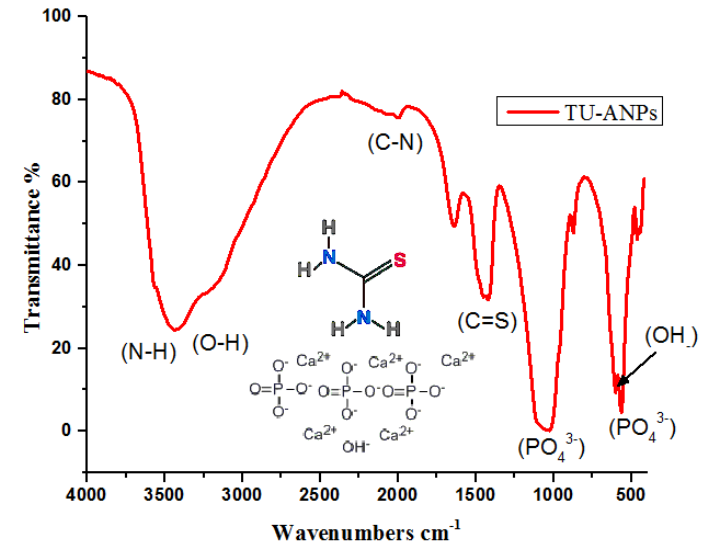
Figure 1. Infrared spectroscopy of TU-ANPs representing various vibrational stretches and bending of functional groups associated with thiourea and apatite.